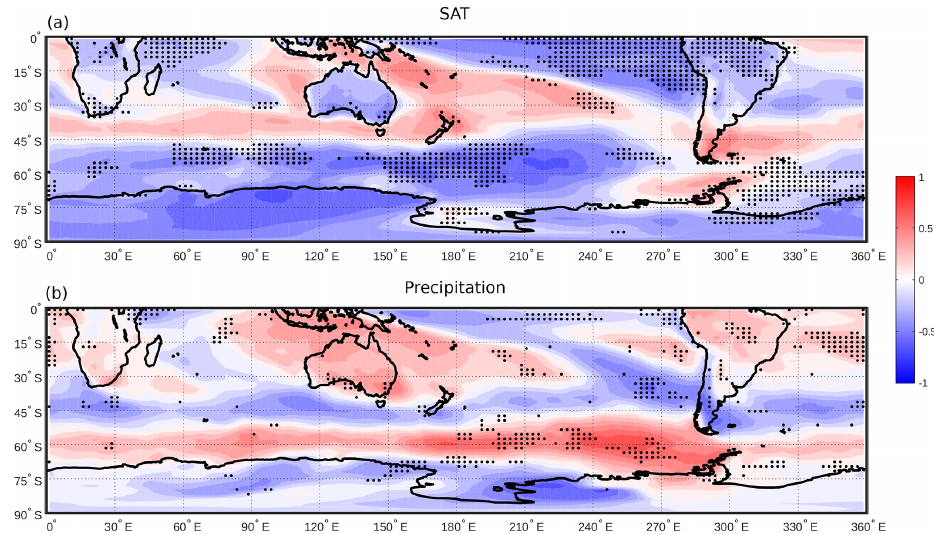
Figure 1. Correlations of annual-mean (January–December) SAT (a) and precipitation (b) from the GFDL CM2.1 model with the model- derived SAM, calculated over 500 years. Black dots show where the correlation of the ERA-Interim reanalysis product with the Marshall SAM index, calculated over a 36 year period from 1979 to 2014, does not fall within the range of the model’s 36 year running correlation at each grid